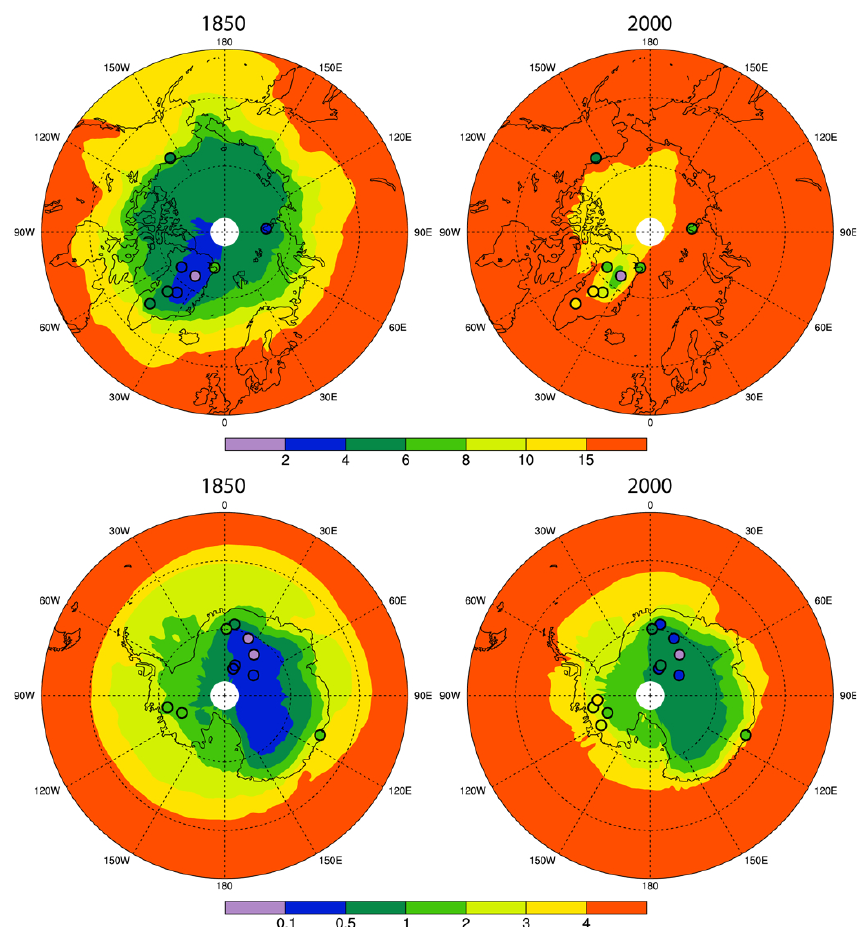
Fig. 4a. Nitrate deposition from ice cores (mg(N)m − 2 yr − 1 , filled circles, see Table S5) and MMM for 1850 (left column) and 2000 (right column). Top panel is for the Arctic region; bottom panel is for the Antarctic region. Contours are the MMM results; filled circles are the observations. Note different color scales between top and bottom